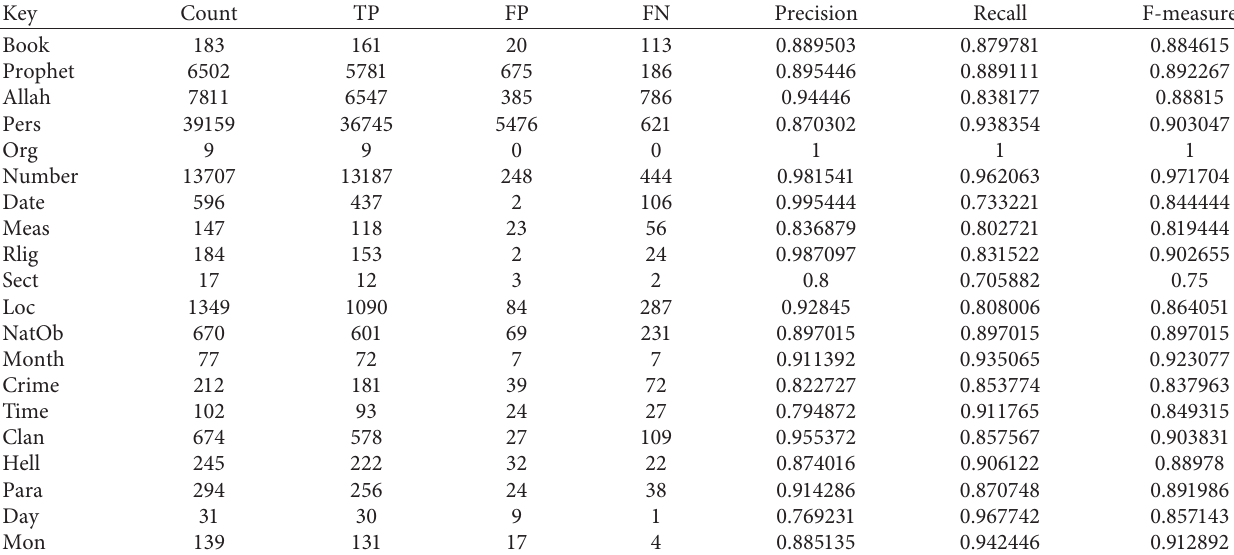
Table 14: Results of not using grammar rules.